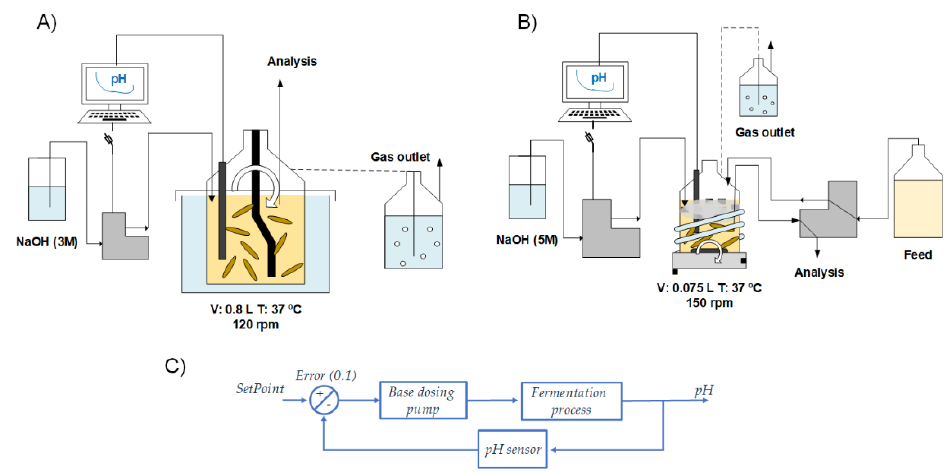
Figure 1. Fermentations setup with C. acetobutylicum DSM 792. ( A ) Batch fermentations, ( B ) continuous fermentation and ( C ) block diagram for the pH.